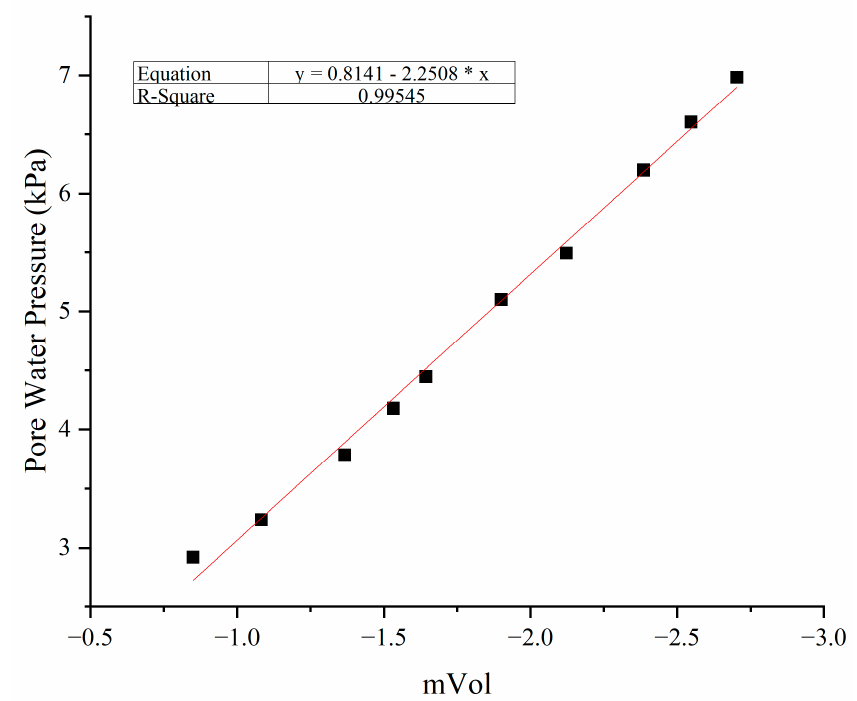
Figure 3. A typical calibration curve for pore water pressure and